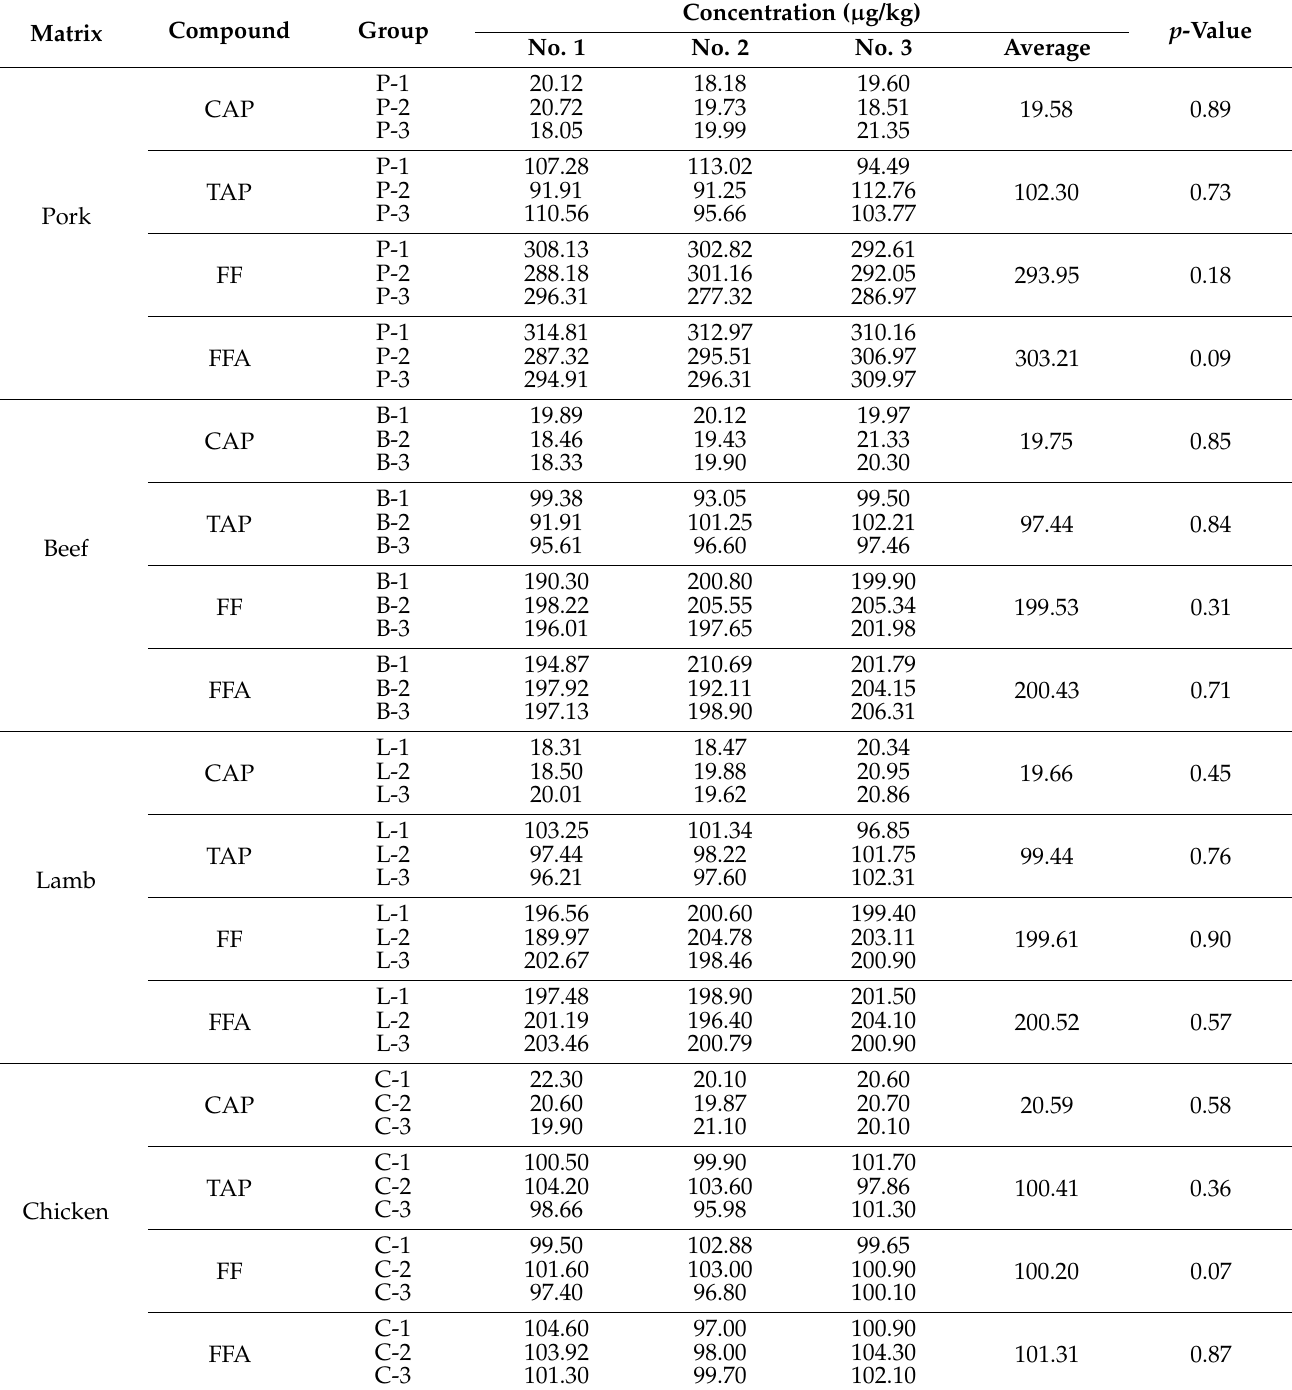
Table 4. Homogeneity analysis of amphenicols and metabolites added to livestock and poultry meat